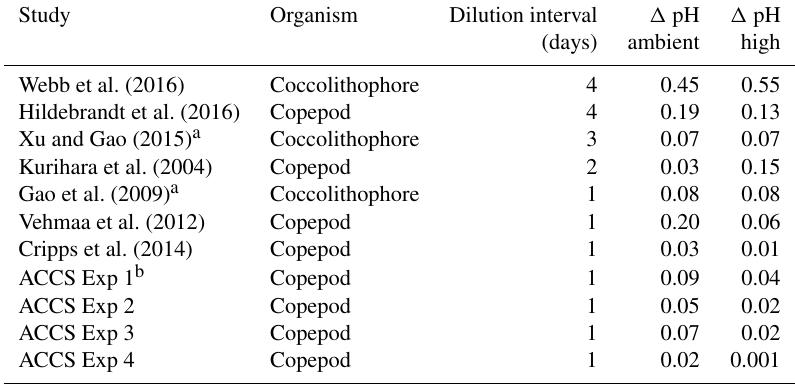
Table 1. Comparison of daily variability in pH (total hydrogen ion scale) in semi-continuous OA studies without direct bubbling. (cid:49) pH is the mean absolute difference between pH before and after dilution (where available). Dilution interval indicates days between dilution of cultures. Ambient conditions are nominally between 380 and 450µatmCO 2 . High conditions are nominally between 1000 and 2000µatmCO 2 . All studies apart from ACCS experiments are simple semi-continuous cultures with closed conditions between dilutions.